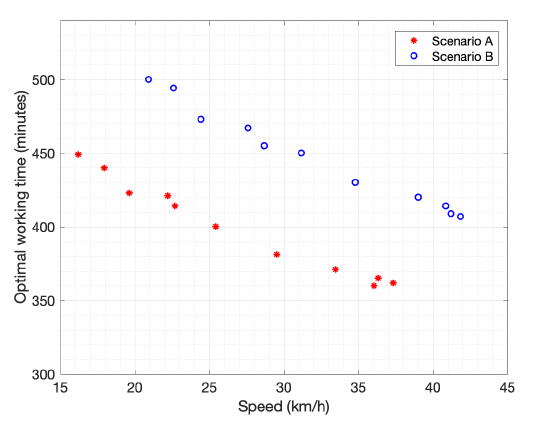
Figure 9. Optimal working time τ ∗ as a function of road average